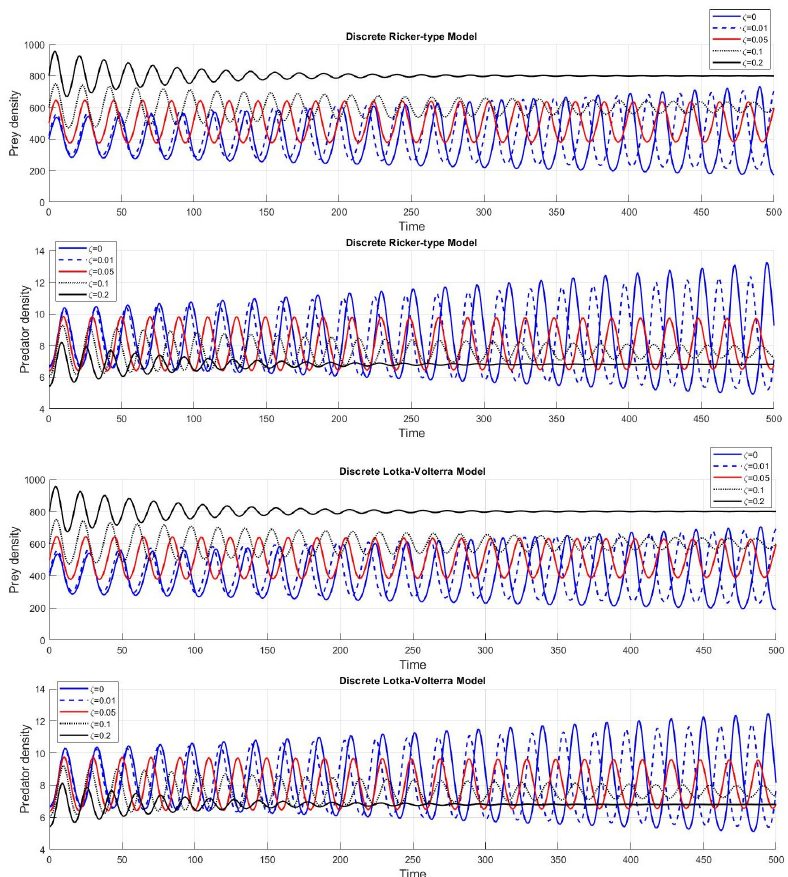
Figure 2. Different predator-prey dynamics of discrete Ricker-type and Lotka-Volterra models with slightly varying parameter c as c + ζ by ζ = { 0,0.01,0.05,0.1,0.2 } values where h = 1, K = 2500, γ = 0.01, α = 0.05, c = 0.2 and r =